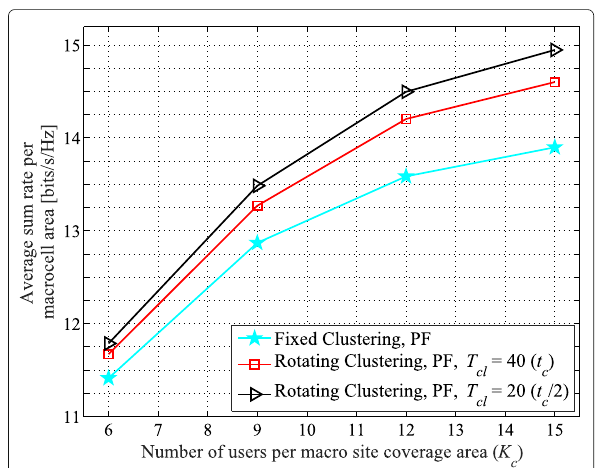
Fig. 12 Average achievable sum rate vs. K c with proportionally fair (PF) scheduling ( t c = 40) over the area of a macrocell in an arbitrary cluster,comparingvarious T cl forproposedrotatingclusteringscheme and fixed clustering for three-cell layout, using simulated annealing scheduling and SZF-DPC precoding. N macro = N pico = 2, M =